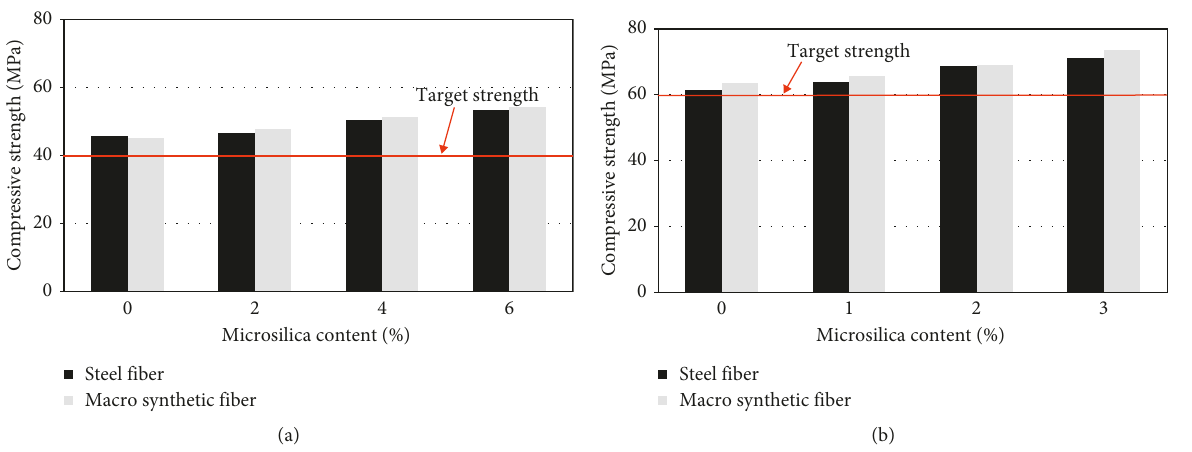
Figure 2: Compressive strength by microsilica content. Target strength of (a) 40MPa and (b) 60MPa.